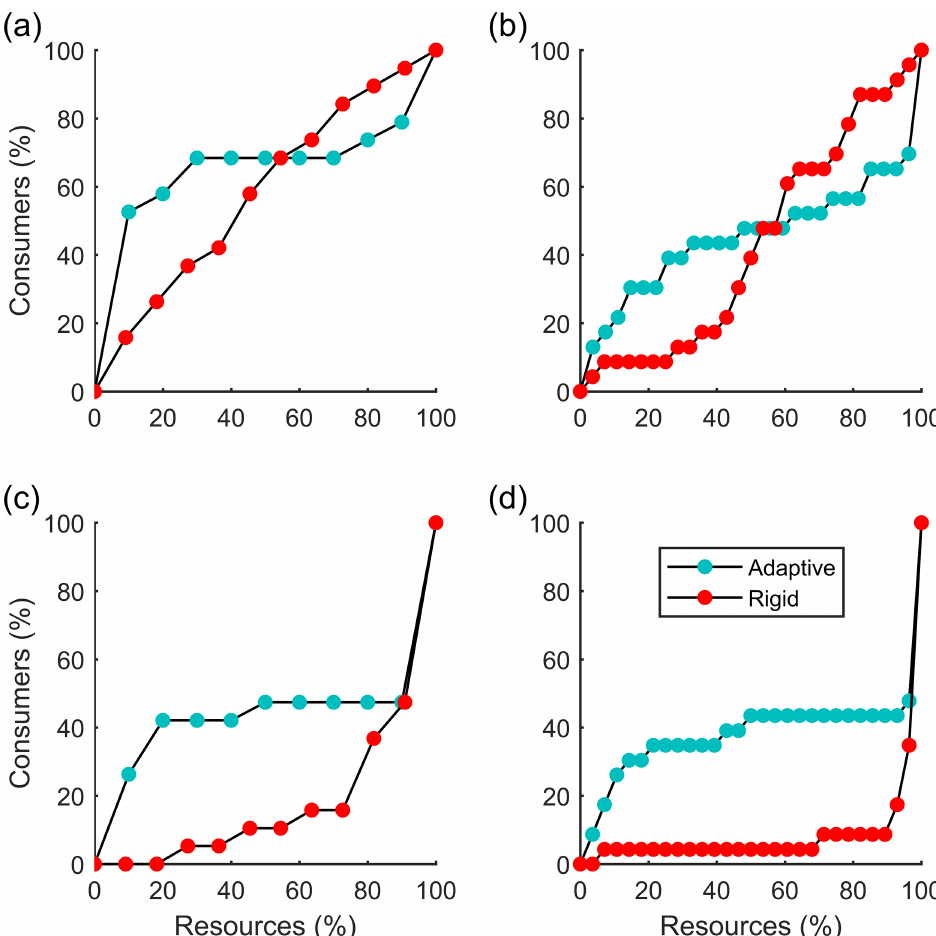
Fig 3. Robustness to the removal of species in adaptive and rigid networks. Panels(a) and (c) correspond to the real network, N41 while (b) and (d) correspondto N43 in S1 Table in the supporting information. For panels(a) and (b), generalistspecieswere sequentially removedwhile for (c) and (d), specialistswere sequentially removed. Points show the percentageof consumer extinctionsthat resultedfrom the removalof a certain percentageof generalist (a and b) or specialist(c and d) resource species from an adaptiveor rigid network.